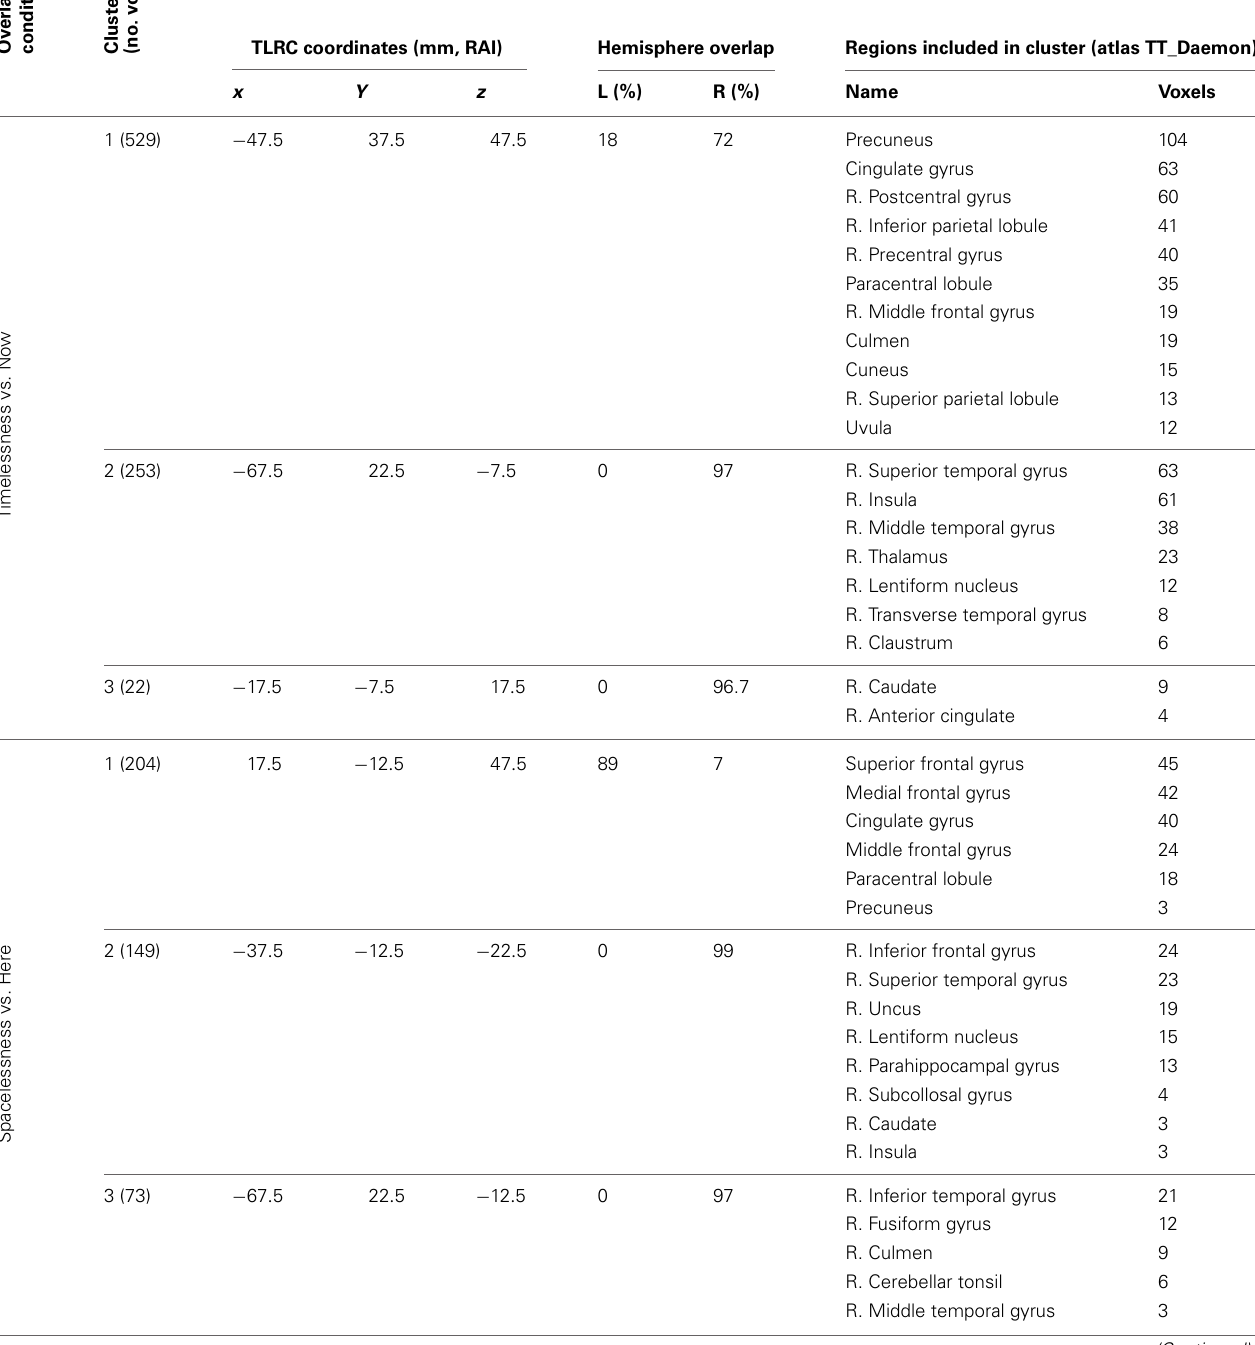
Table 2 | Beamforming solutions for the contrasts Timelessness vs. Now and Spacelessness vs. Here in the theta (4–8Hz) frequency band ( n =